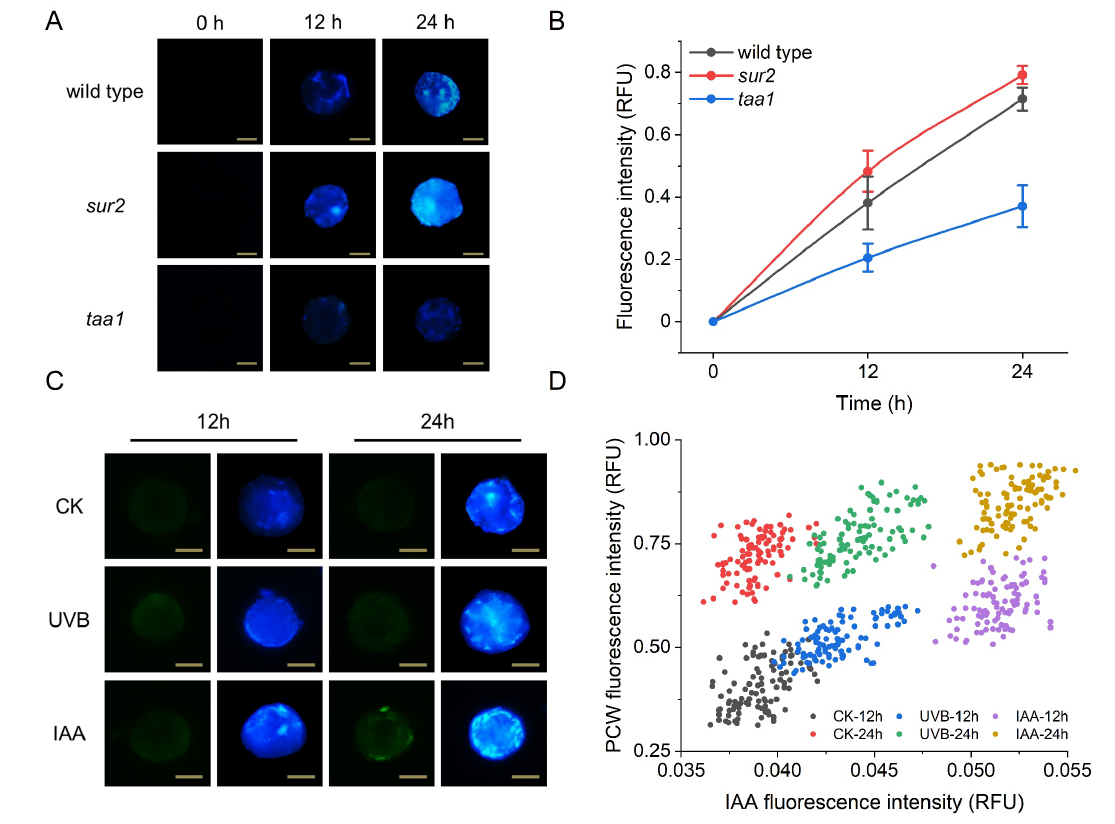
Figure 5. Involvement of auxin in PCW regeneration progress. ( A ) PCW fluorescence images of protoplasts of different Arabidopsis genotypes at three time points with a scale bar of 25 μm; ( B ) Fluorescence intensity of protoplasts of different Arabidopsis genotypes; ( C ) IAA distribution and PCW fluorescence images of DRF-GFP under the influence of UVB irradiation and exogenous IAA; ( D ) Two-channel detection of IAA autofluorescence and PCW fluorescence from DRF-GFP protoplasts.